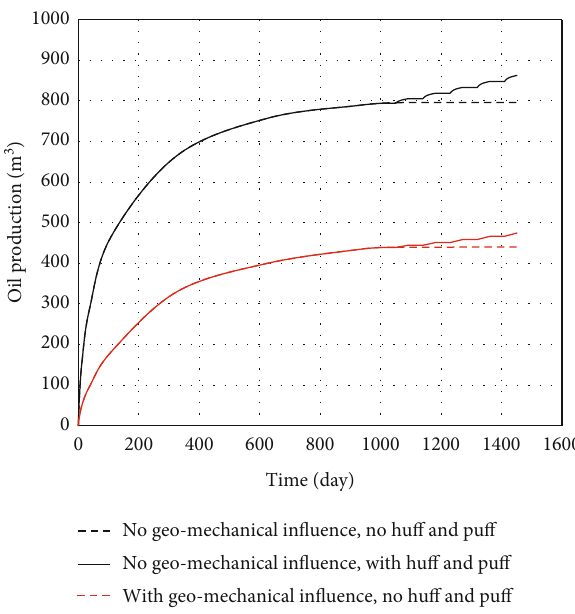
Figure 8: Comparison of cumulative production calculated with the two